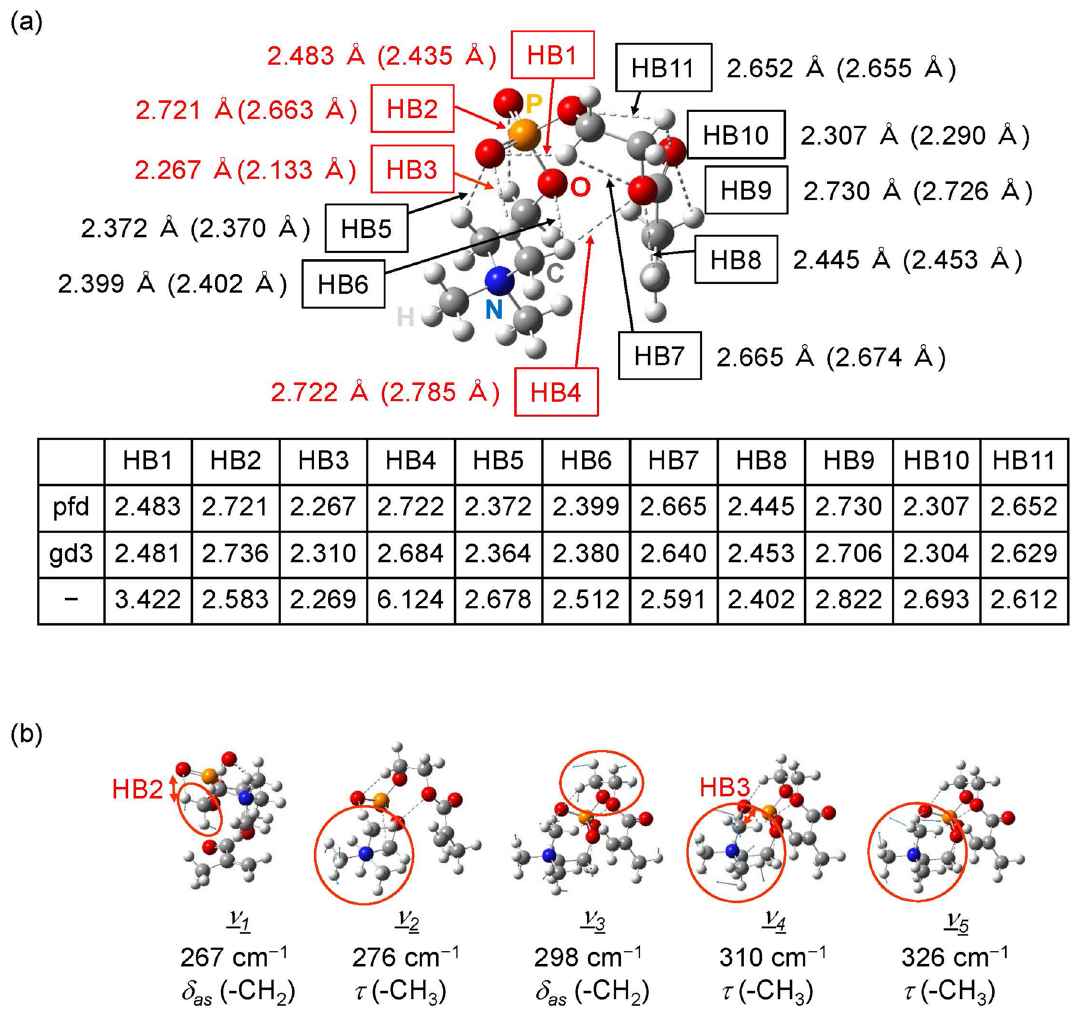
Figure 4. ( a ) Intramolecular hydrogen bond distances of the most likely conformer of MPC calculated at a dielectric constant of 4.20. Intramolecular hydrogen bonds, HB1–HB11, are indicated by the dashed lines. The bond lengths at a dielectric constant of 2.07 are given in parentheses. The four hydrogen bonds that show a remarkable change in length due to the difference in dielectric constant are marked in red. The table shows the optimized bond lengths in Å calculated at the dielectric constant of 4.20 with the Petersson-Frisch dispersion model (pfd) 40 , the D3 version of Grimme’s dispersion (gd3) 41 , and without dispersion correction (–). ( b ) Vibrational modes given as ν 1 – ν 5 in the right panel in Fig. 3b ( δ as : asymmetric bending in plane or rocking, τ : torsion). The frequency of each mode is the result calculated with a dielectric constant of 4.20 using the pfd model for dispersion correction. Intramolecular hydrogen bonds are indicated by the dashed lines. The blue arrows indicate the atomic displacement vectors. Mainly moving parts are marked with red circles. The stretching vibration of an intramolecular hydrogen bond is indicated by a red arrow along with the name of hydrogen Figure 4a shows the intramolecular hydrogen bond distances of the most likely conformer. The eleven intra- molecular CH…O distances are calculated to be less than 2.77 Å (the limit of VDW contacts for weak hydrogen bonds at the same level of calculations 19 ) at a dielectric constant of 4.20, which suggests the formation of weak hydrogen bonds. The bond lengths of HB1–HB11 calculated with different dispersion corrections are found to be the same within a difference of 0.04 Å (table in Fig. 4a). The bond length larger than 2.77 Å for HB1, HB4, and HB9 calculated without dispersion correction suggests that the dispersion force mainly contributes to the hydro- gen bonds of HB1, HB4, and HB9, stabilizing the conformation. When comparing the intramolecular hydrogen bond distances between the results calculated with dielectric constants of 4.20 and 2.07, the four intramolecular hydrogen bonds HB1–HB4 marked in red showed remarkable changes in distance. At high dielectric constant corresponding to low temperatures, the distances of HB1–HB3 are significantly elongated, and the distance of HB4 is shortened. The distance of HB4 at ε = 2.07 that corresponds to high temperatures is longer than 2.77 Å , suggesting that a bond break occurs. The opposite change with a change of dielectric constant in distance of HB4 to that of HB1–HB3 can be interpreted by a change in N + –O − distance. Changes in dielectric constant affect the electrostatic charge-charge interaction between negative oxygen on phosphorus and positive nitrogen, causing